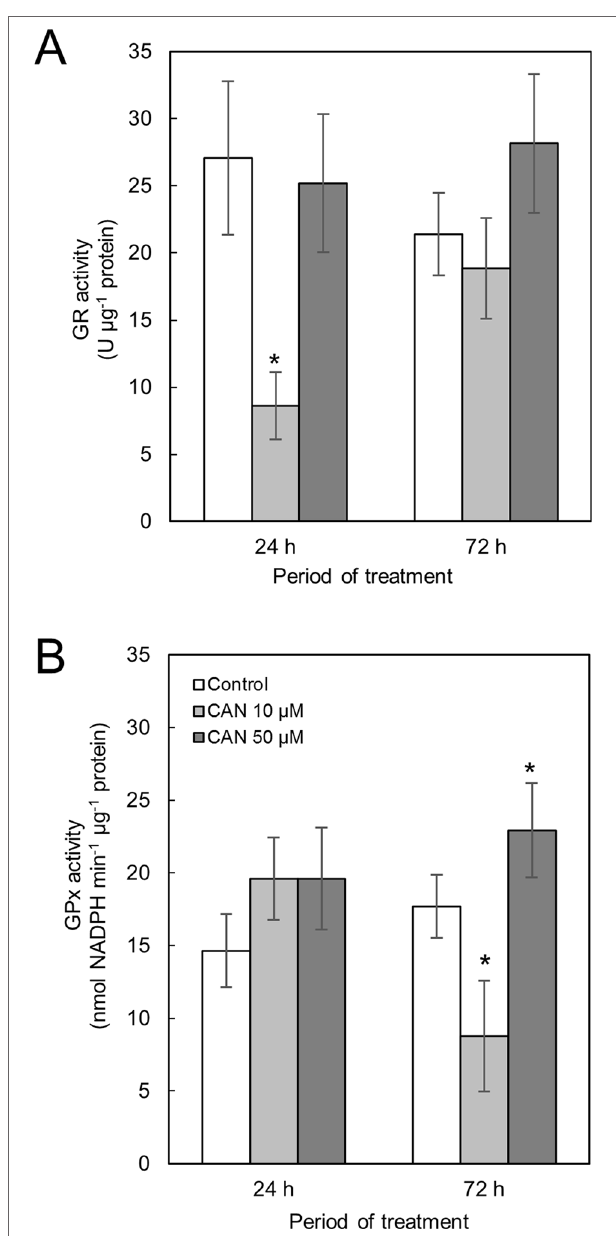
FIGURE 3 | Activity of GR (A) and GPx (B) in extracts from roots of the control seedlings growing in water and roots of seedlings treated with CAN (10 or 50 µM) for 24 and 72 h. Values are average ± SD of at least three independent experiments and three biological repetitions each. Asterisks (*) indicate significance between treatments and the control at the same time of culture period at P ≤ 0.05, based on Student’s